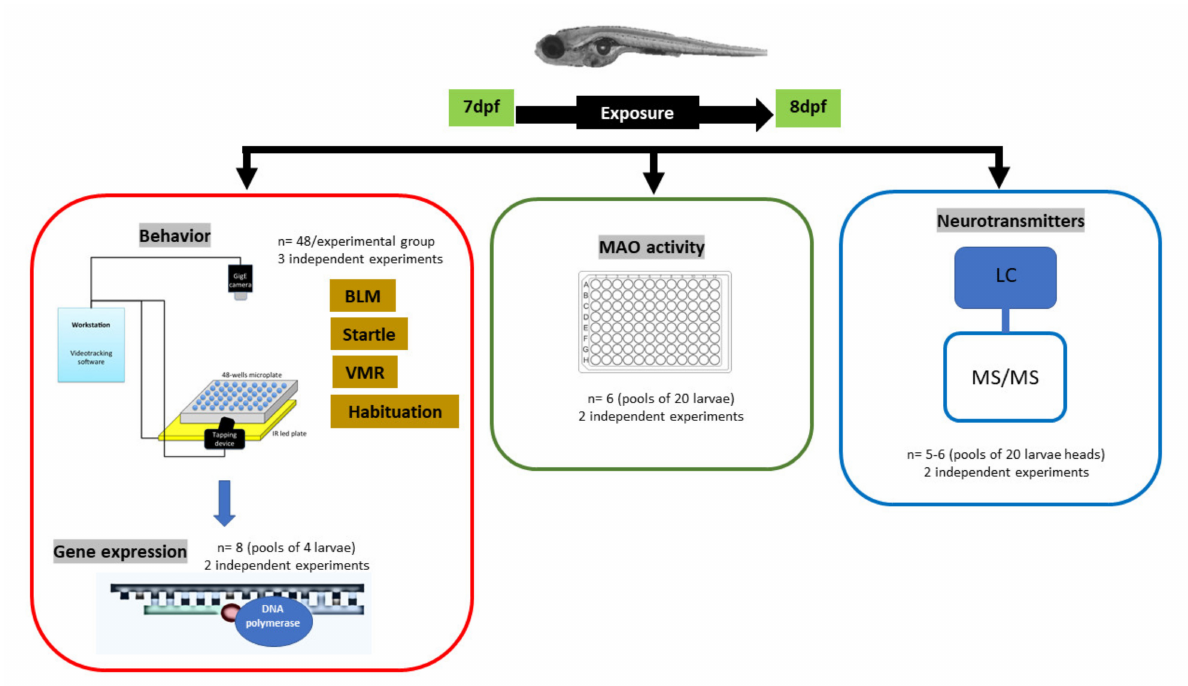
Figure 1. Diagram of the conducted study, indicating the exposure period (from 7 to 8 dpf) and the addressed variables (behavior, gene expression, MAO activity, and neurotransmitters), divided into their corresponding dataset (red, green, and blue squares). Indicated are also the number of larvae and independent experiments used for each